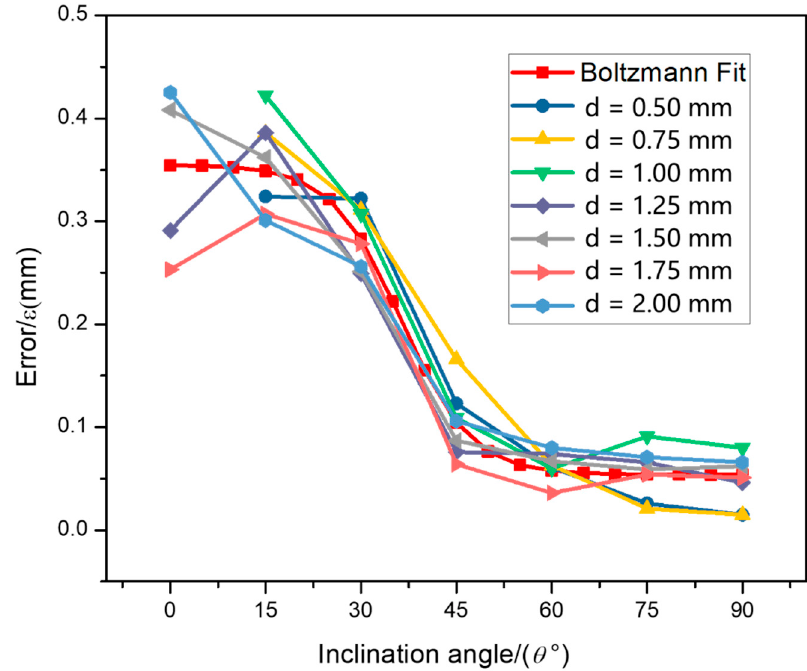
Figure 13. Comparison of longitudinal error between Boltzmann curve fitting and actual rod